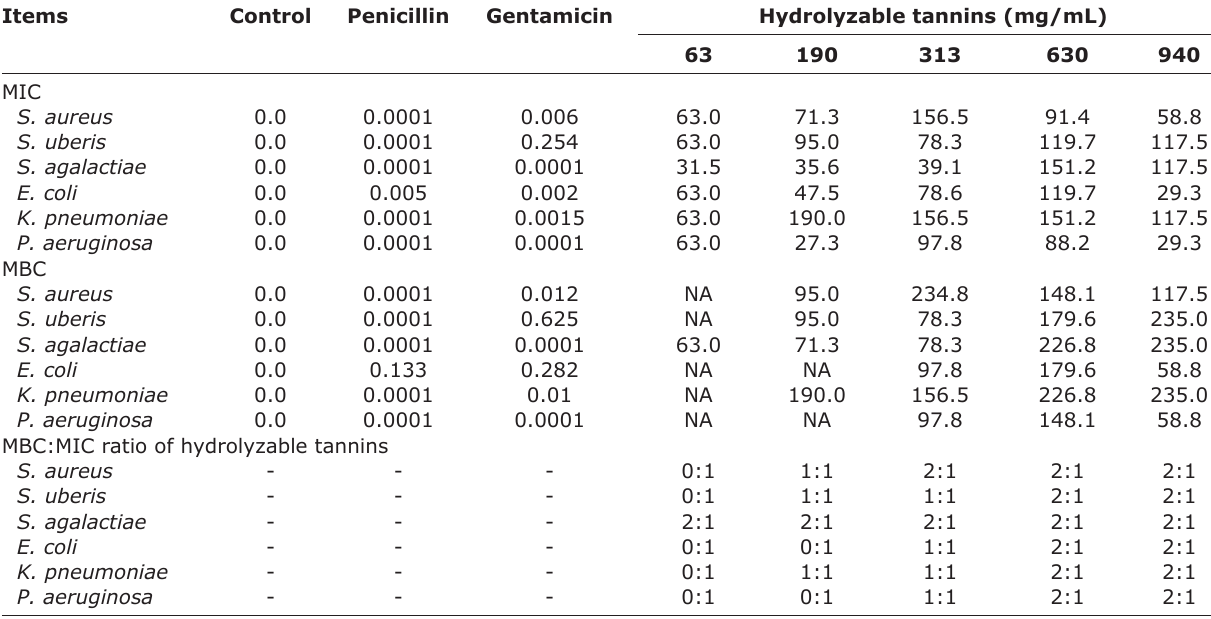
Table-2: MIC, MBC, and MBC:MIC ratio of hydrolyzable tannins against bacteria isolates.